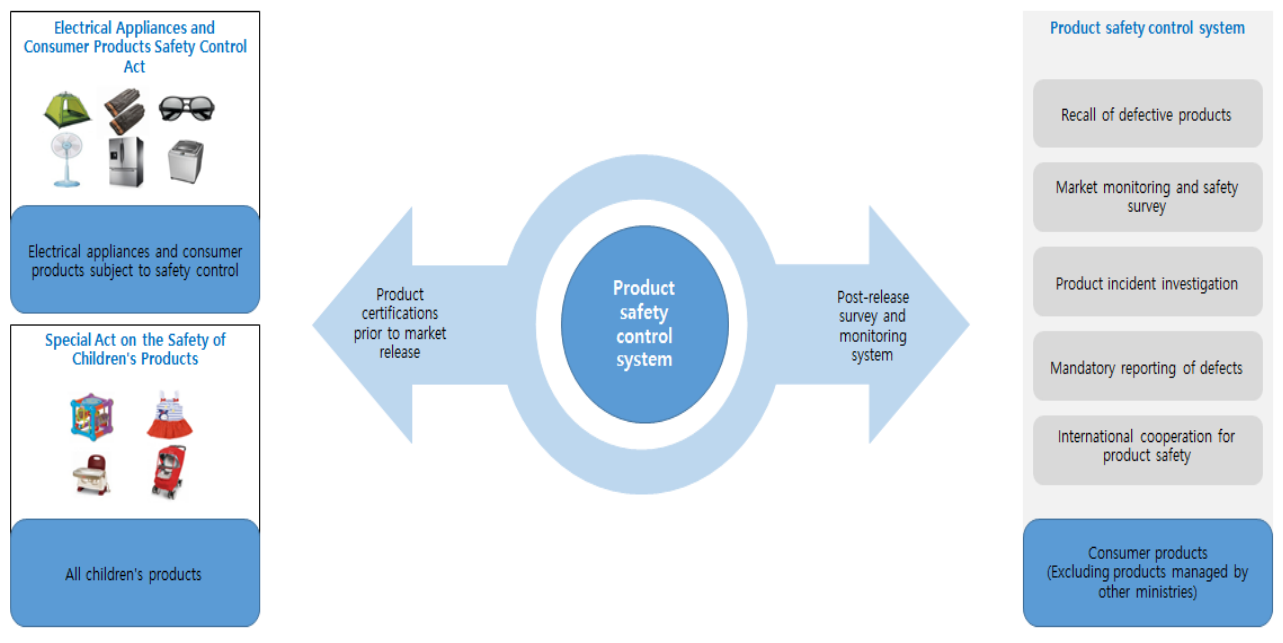
Figure 2. Product Safety Management System.